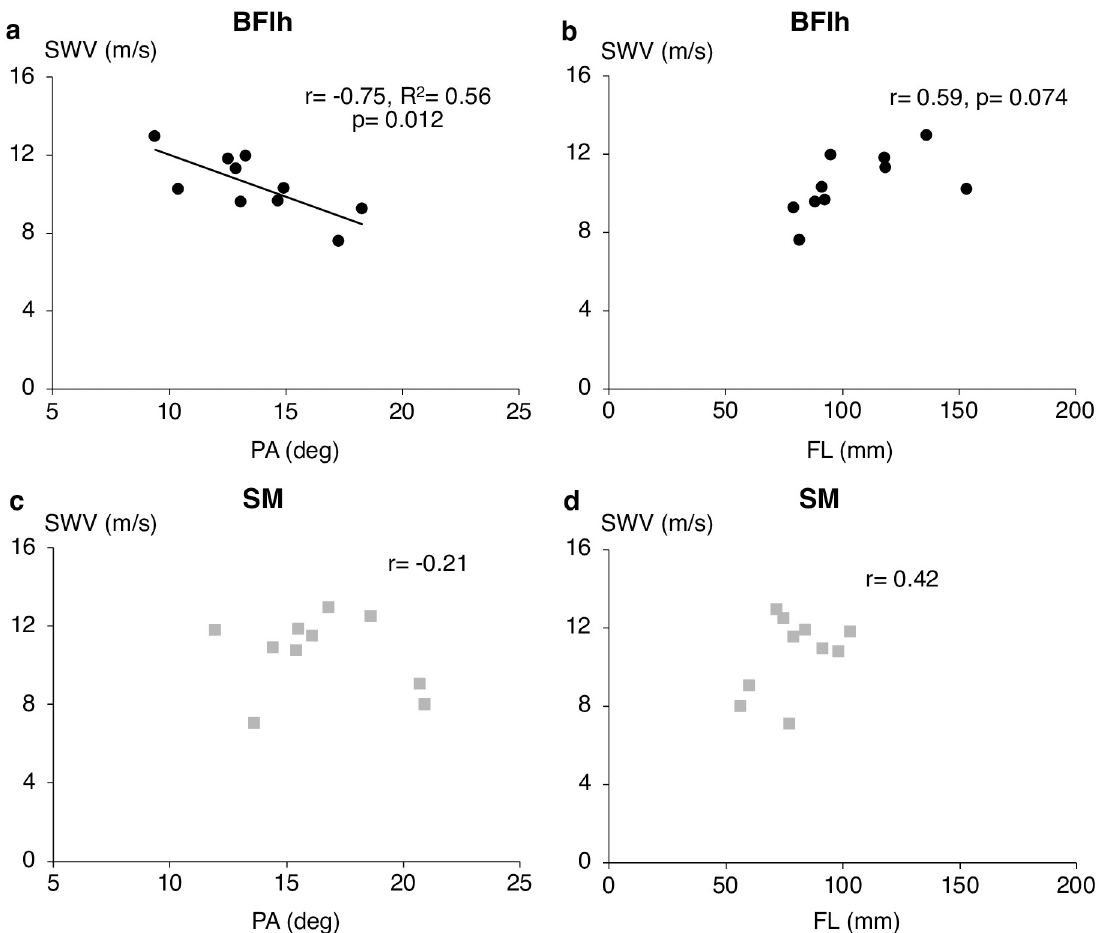
Fig 5. Relationships between hamstrings muscle architecture and shear wave velocity. Bivariate correlations between peak isometric shear wave velocity (SWV) and pennation angle (PA) and fascicle length (FL) for biceps femoris long head (a, b) and semimembranosus (c,